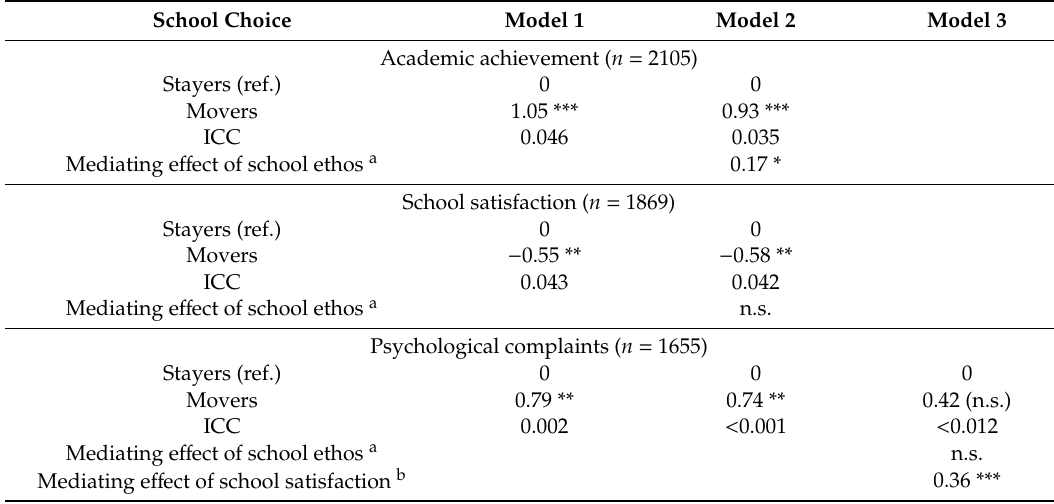
Table 2. Results from two-level random intercept linear regression models (b coe ffi cients). Student-reported academic achievement, school satisfaction and psychological complaints according to school choice group (based on all the available information of the ninth-grade students in the study sample taking part in the Stockholm School Survey in 2014 and